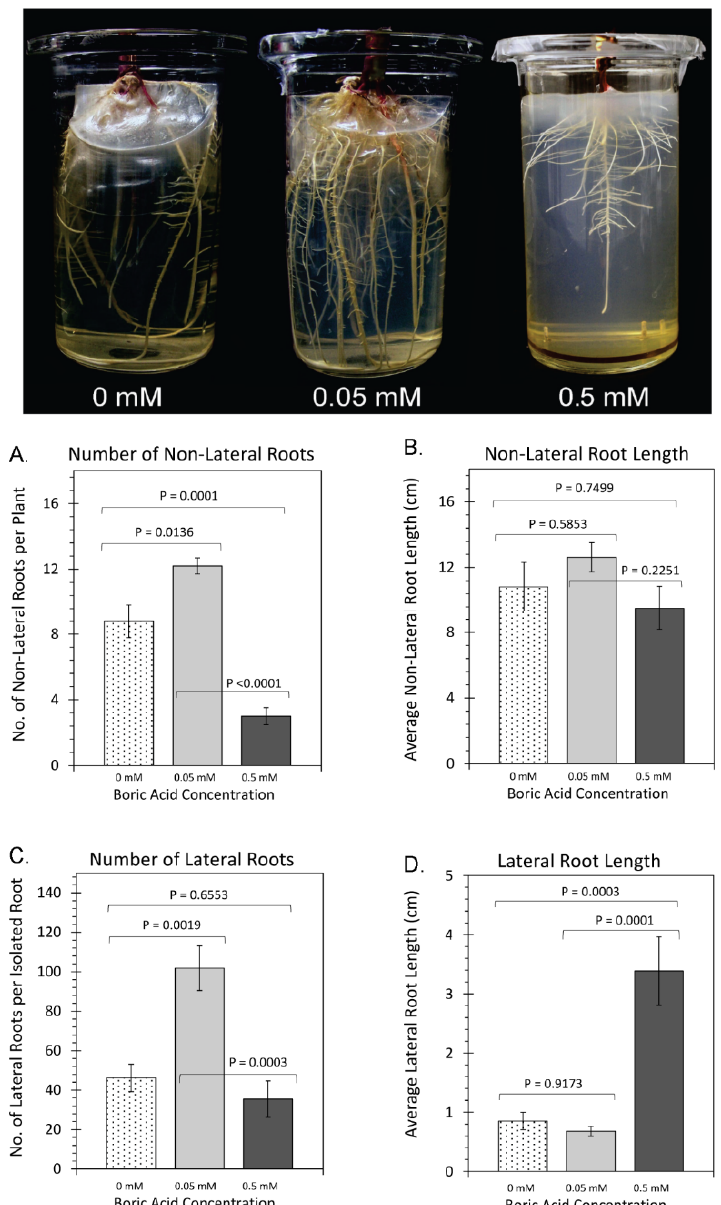
Figure 3. Root growth traits: upper panel depicts photos of plants that were grown under three regimes of boric acid (BA) treatment, including: 0 mM BA, 0.05 mM BA, and 0.5 mM BA. ( A ) depicts data on the average number of non-lateral roots (includes primary, seminal, and nodal roots) per plant. ( B ) depicts data on the average non-lateral root length measured in centimeters. ( C ) depicts data on the average number of lateral roots per root. ( D ) depicts data on the average lateral root length measured in centimeters. All data bars represent average values ± SE from N = 8–10 replicates. Data was subjected to one-way analysis of variance with a post hoc Tukey’s HSD test to account for multiple comparisons between the different treatment groups (0 mM-to-0.05 mM BA; 0.5 mM-to-0.05 mM BA; and 0 mM-to-0.5 mM BA). Statistical significance was set at p <